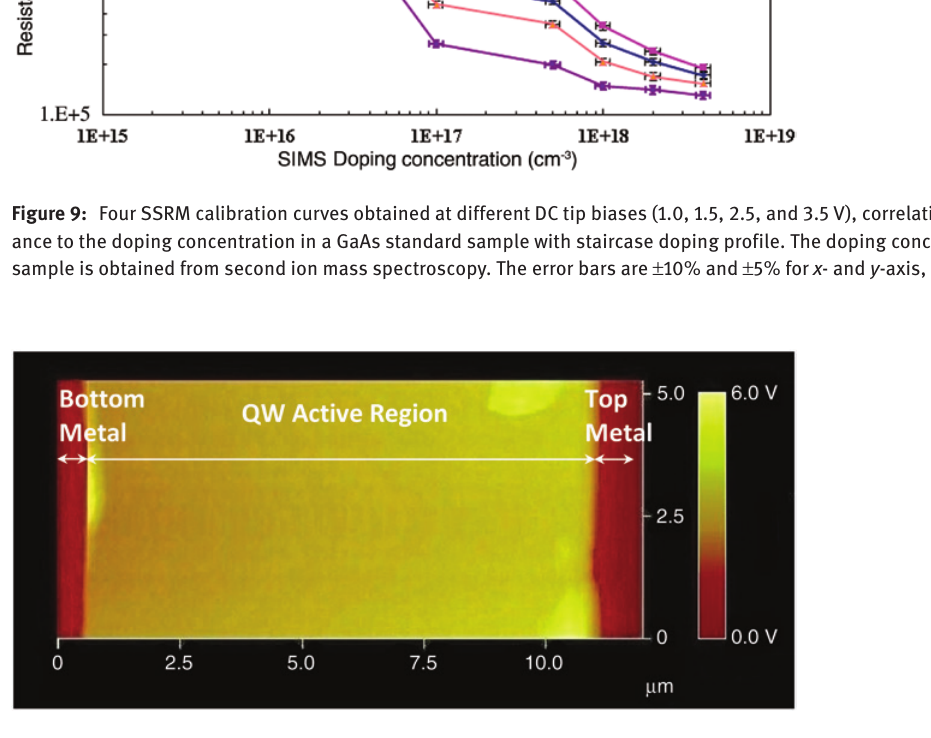
Figure 10: SCM image of the transverse cross section of the emission facet of V843. The AC tip bias is 1.0 V, the scan rate is 0.5 Hz, and the scan area is 5 × 12 μ m 2